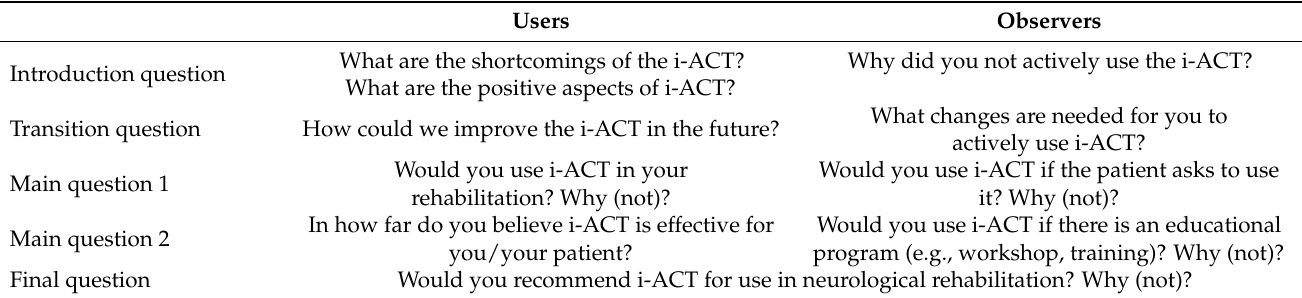
Table A1. Topic list semi-structured